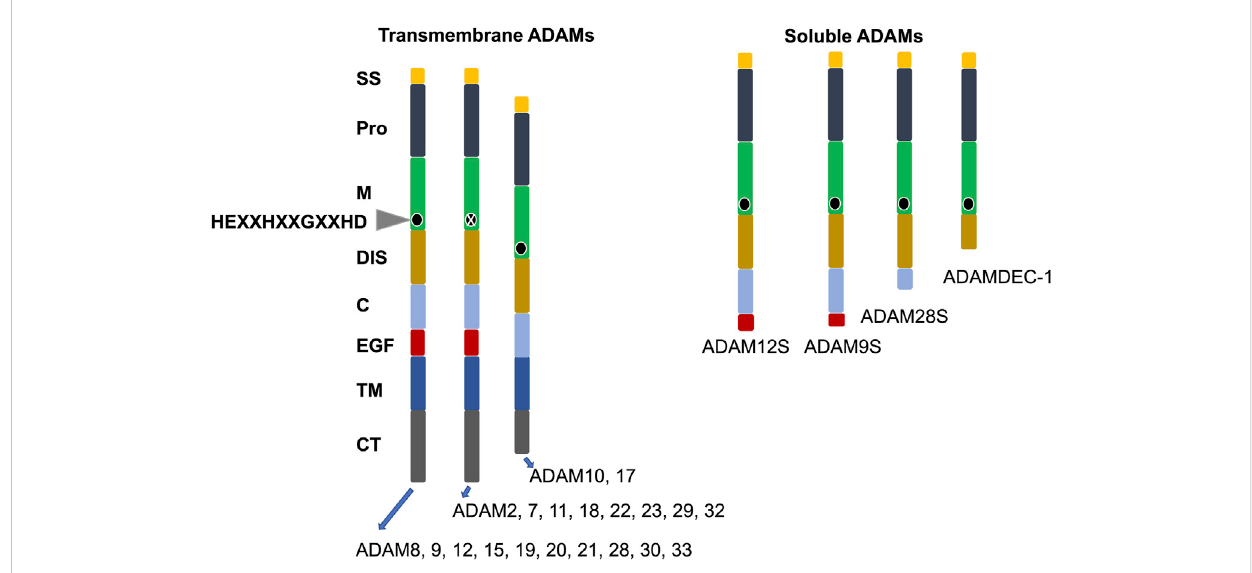
FIGURE 1 Structural organization of the family of human ADAMs. ADAMs are divided in transmembrane and soluble subgroups. The conserved active site of amino acids is indicated by a black circle. X stands for ADAMs without a conserved active site sequence in their M domain. C, cysteine-rich; CT, cytoplasmic tail; DIS, disintegrin-like; EGF, epidermal growth factor-like; M, metalloproteinase; Pro, prodomain, and SS, signal